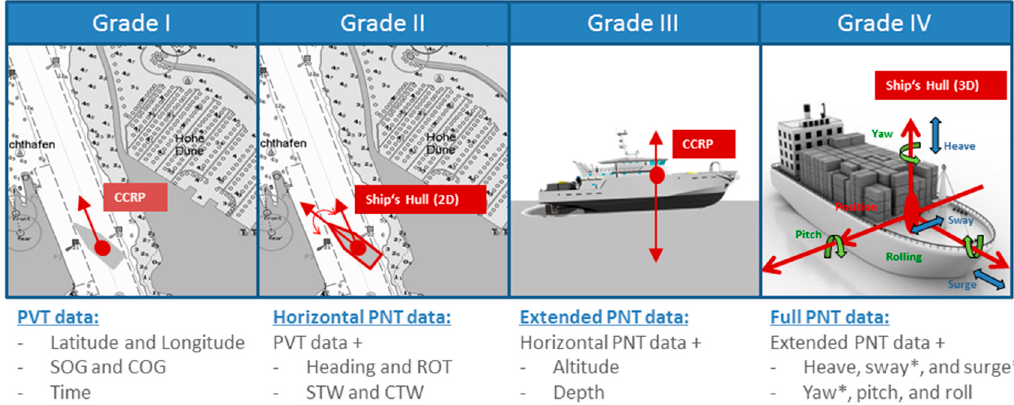
Figure 1. Grade I to IV specify the amount and types of PNT data needed for specific navigational applications and phases, as defined in [32] (CCRP—consistent common reference point, PVT—position, velocity, and time, SOG—speed-over-ground, COG—course-over-ground, STW—speed-through-water, CTW—course-Through-water; * stands for improved accuracy and integrity in comparison to Grade II).